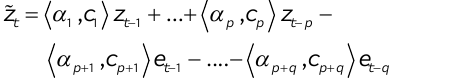
Stage 4: Designing and training a Probabilistic Neural Network